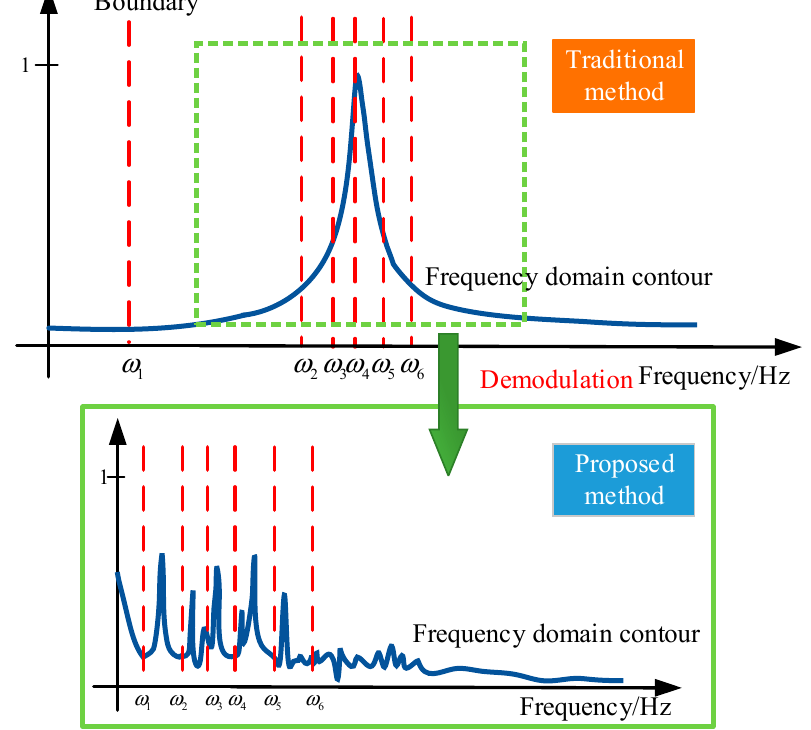
Figure 2. Comparison of boundary detection mechanism between the proposed method and traditional method.